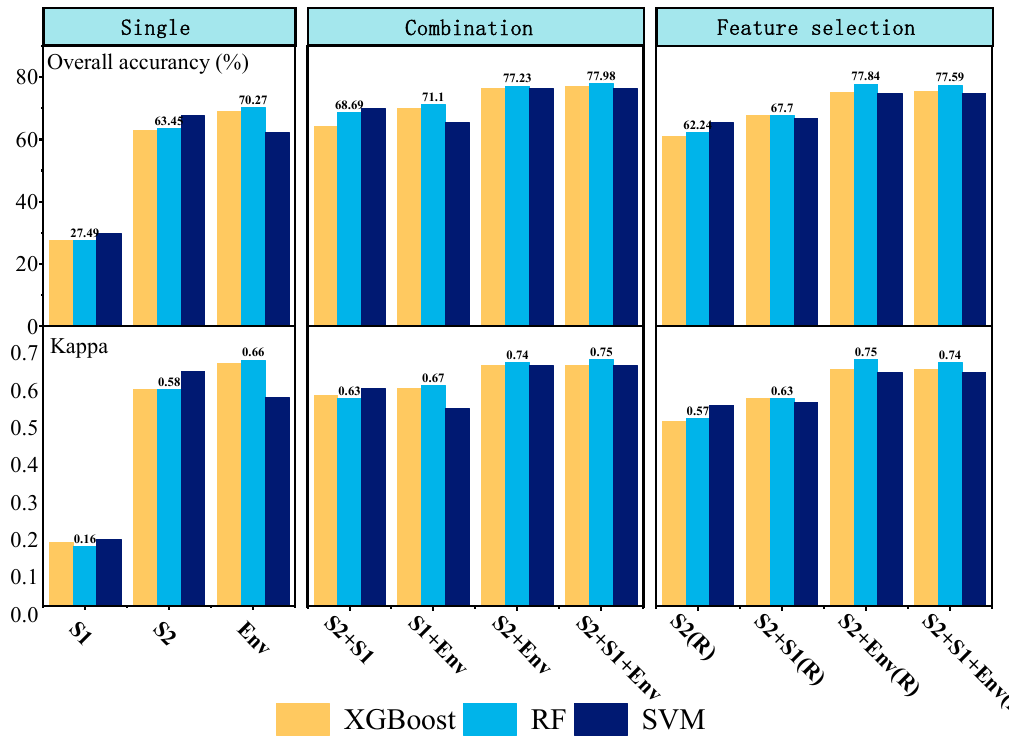
Figure 4. Classification accuracies were obtained from different classification cases and three clas- sifiers.